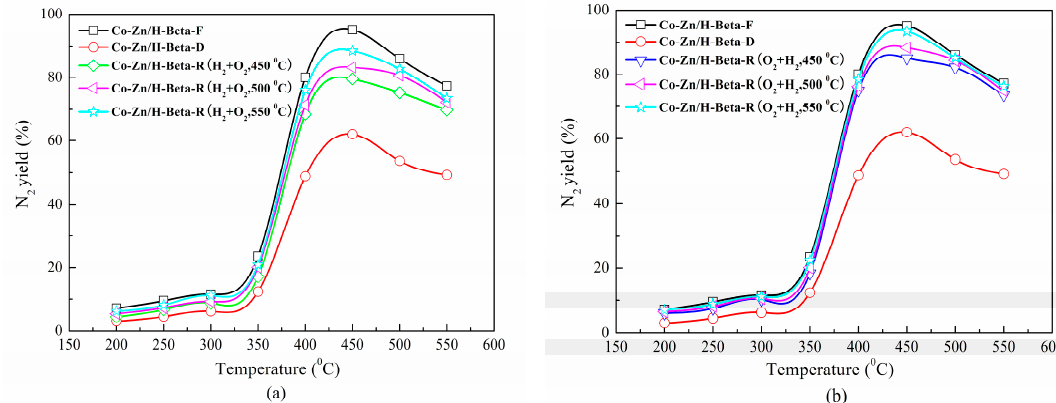
Figure 3. Optimization of regeneration temperature for ( a ) H 2 reduction followed by air oxidation and ( b ) air oxidation followed by H 2 reduction.